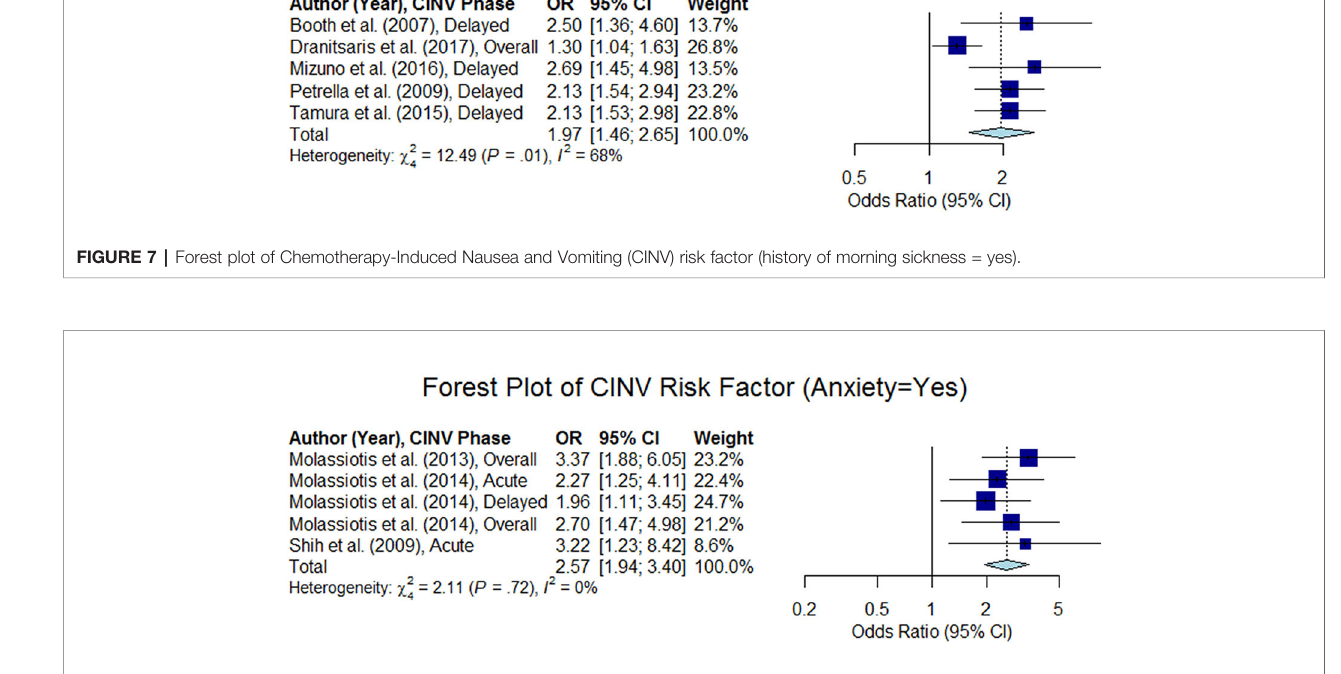
Figure 9 . Molassiotis et al. (2016) considered expectancy of nausea as a continuous variable (0 – 100-mm VAS) and reported the odds ratio to be 1.012 (95% CI 1.006 – 1.018) in